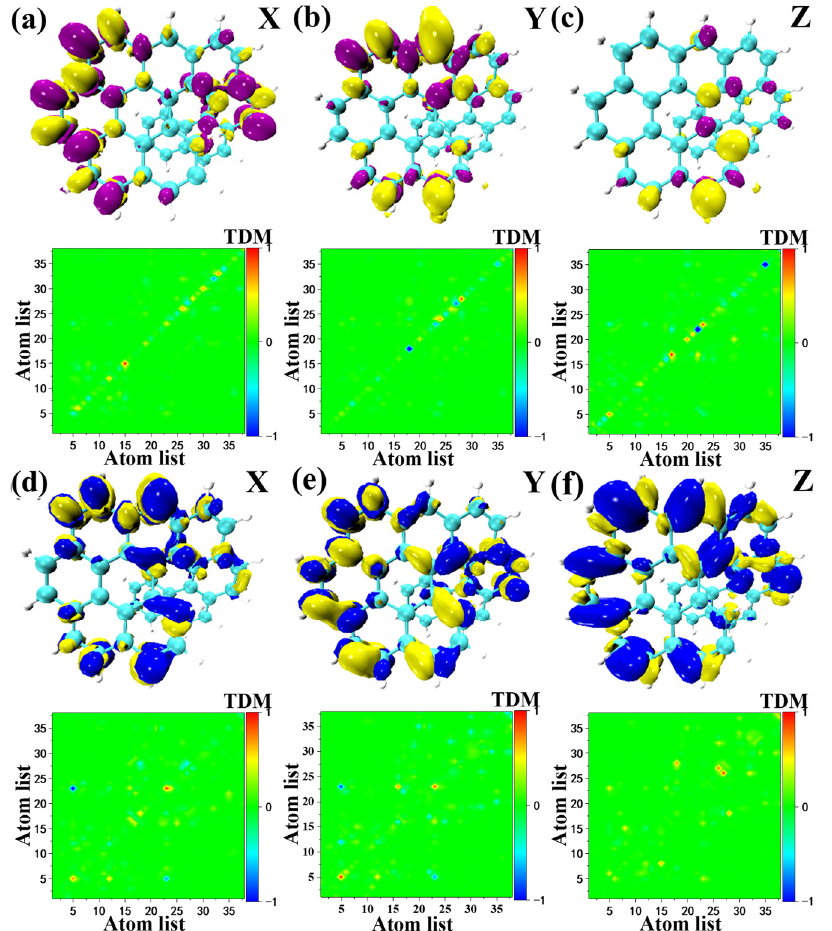
Figure 6. This is a figure. Schemes follow the same formatting. The Cartesian component isosurfaces of the transition electric dipole moment density (yellow and purple isosurfaces) and transition magnetic dipole moment density (yellow and blue isosurfaces) (upper part of ( a – c )) and transition electric and magnetic couples (lower part of ( d – f )) of S 1 of the molecule O9H.